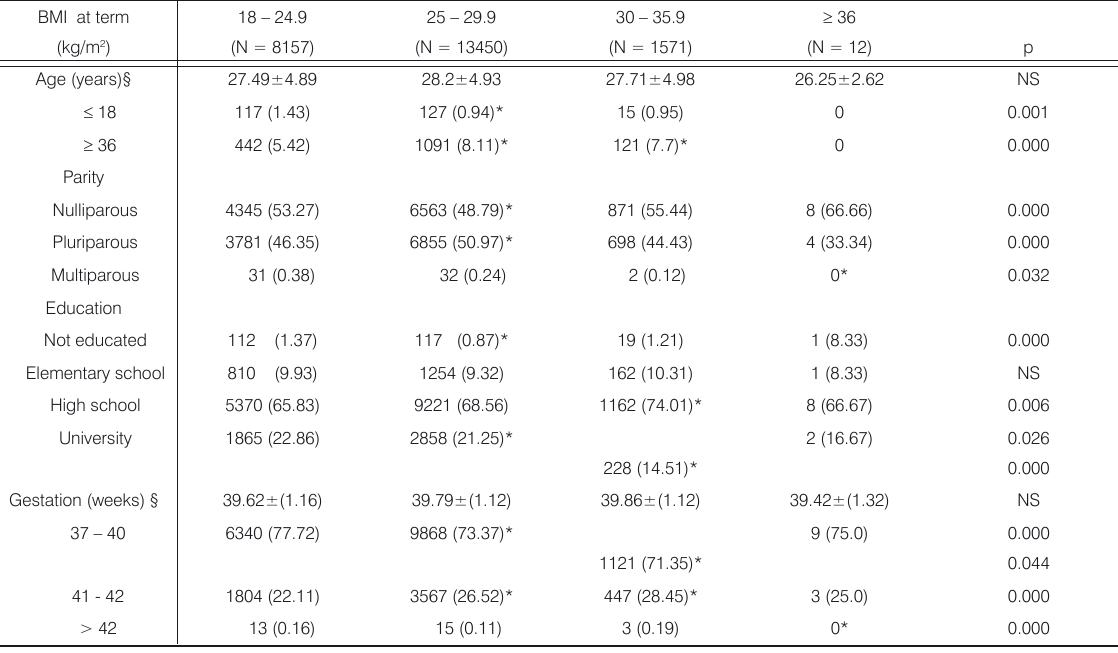
Table 2. The demographic characteristics of women delivering singelton infants during a 10-year period at the Department of Gynecology and Obstetrics, Clinical Hospital Center